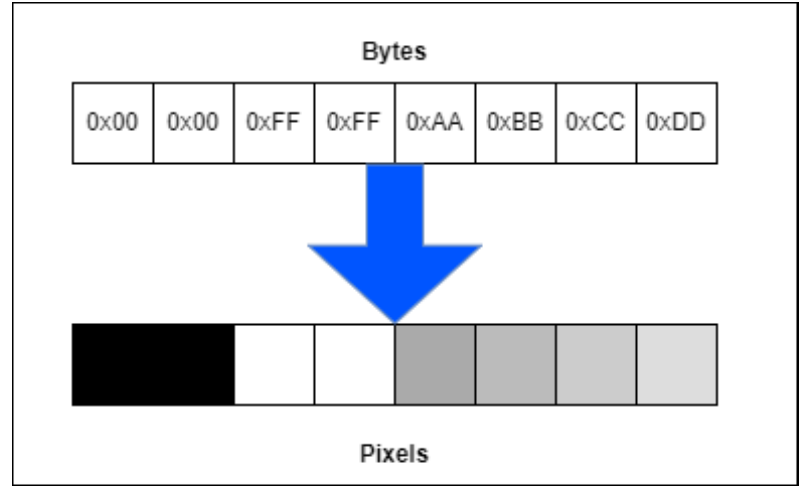
Figure 2. Process of a grayscale image generation from a sequence of